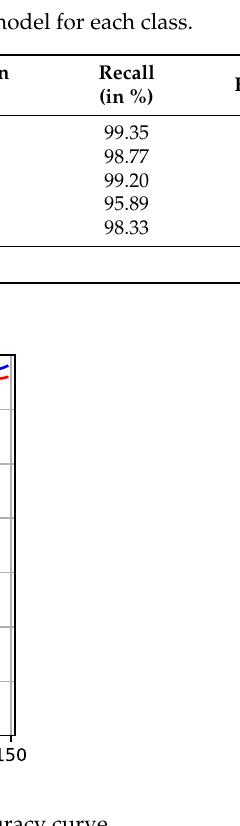
Figure 5. Proposed end-to-end CNN training and validation accuracy